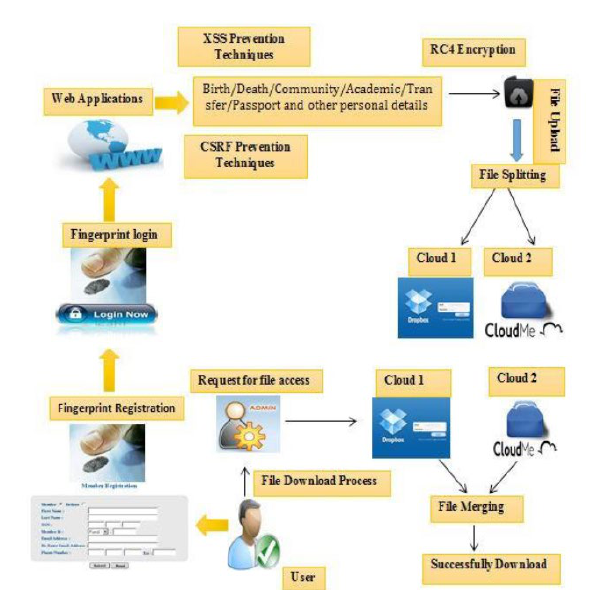
Figure (4). Biometric-based proposed architecture